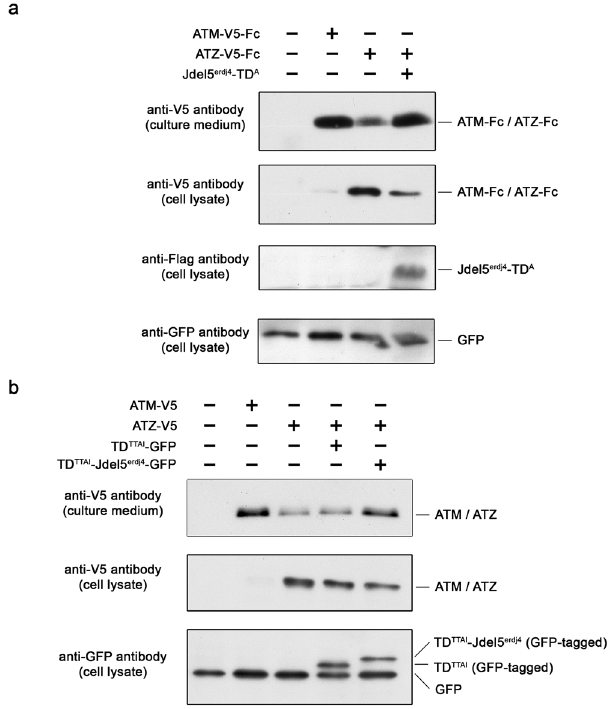
Figure 6. J-domain fragment fusion protein for α 1 antitrypsin deficiency. ( a ) HEK293 cells were transfected to express Fc-fusion proteins of normal M form AT (ATM) or mutant type of AT (ATZ) with ( + ) or without ( − ) a Jdel5 erdj4 fusion protein targeting Fc (Jdel5 erdj4 -TD A ). Two days later, the cell culture medium (top panel) and cell lysate (second, third and bottom panels) were harvested, and ATM-Fc or ATZ-Fc was detected by western blot. ATM-Fc was efficiently secreted (lane 2), while ATZ-Fc was largely retained in cells (lane 3). The co-expression of the fusion protein of Jdel5 erdj4 (Jdel5 erdj4 -TD A ) significantly enhanced the secretion of ATZ-Fc and cleared ATZ-Fc from cells (lane 4). The control (left lane) indicates no transfection control. The cell lysate membrane was subsequently probed with an anti-GFP antibody as a transfection control (bottom panel). ( b ) Jdel5 erdj4 sequence was conjugated to ATZ binding-tetrapeptide (TTAI). Tetrapeptide sequence without Jdel5 erdj4 was used as a control. In order to ensure the expression of the small polypeptide, these polypeptide sequences were expressed as GFP fusion proteins (TTAI- Jdel5 erdj4 -GFP and TTAI-GFP). V5-tagged mutant type of AT (ATZ) was expressed with these polypeptide fusion proteins in HEK293 cells, and expressed ATZ and polypeptide fusion proteins were detected using an anti-V5 antibody or anti-GFP antibody, respectively. GFP without any polypeptide sequence was also expressed to monitor transfection